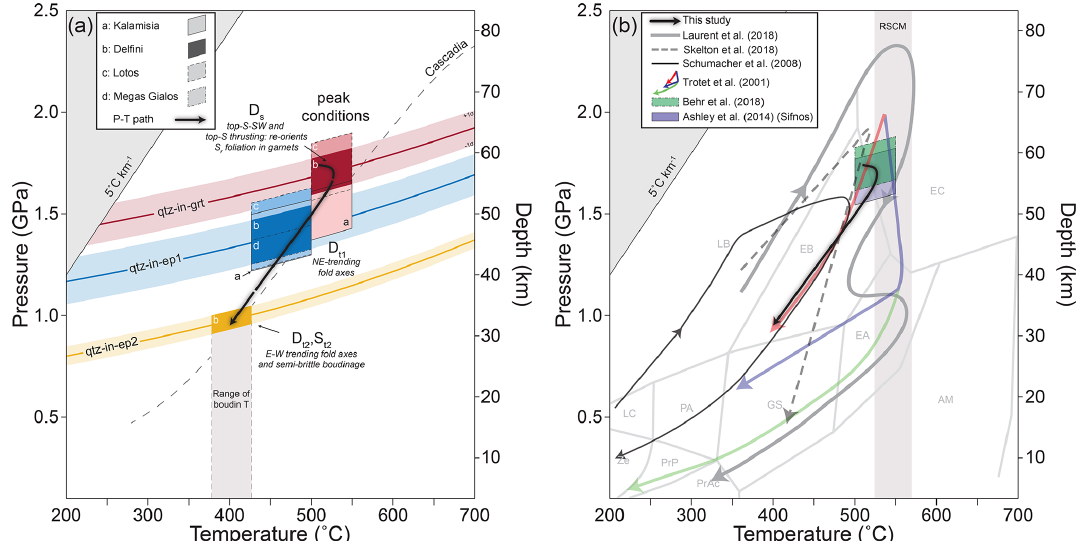
Figure 7. (a) P – T conditions deduced from elastic thermobarometry and oxygen isotope thermometry superimposed on modeled Cascadia slap-top geotherm (Syracuse et al., 2010) and (b) reference P – T conditions. (a) P trap from groups 1, 2, and 3 that reflect peak (qtz-in- garnet), retrograde blueschist–greenschist facies (qtz-in-ep1, D t1 ), and late greenschist facies (qtz-in-ep2, D t2 ) conditions. Solid red, blue, and yellow lines and rectangles are the P trap isomekes (calculated from the mean residual inclusion pressure of each group) and our best- estimate entrapment conditions, respectively. Transparent lines are P trap errors (1 σ around the mean) for analyses from Delfini samples. Gray box bounds the range of temperatures calculated from oxygen isotope thermometry of quartz–calcite boudin-neck precipitates. D s is the oldest stage of deformation in outcrop. Subsequent D t deformation is separated into D t1 and D t2 to differentiate between older and younger stages of upright folding, respectively, that form NE–SW (D t1 ) and E–W (D t2 ) lineations under blueschist and greenschist facies conditions. (b) Recalculated P trap values from Behr et al. (2018) (Syros) and Ashley et al. (2014) (Sifnos) and shown in purple (solid border) and green (dashed border) rectangles, respectively. Metamorphic facies are taken from (Peacock, 1993). Metamorphic facies fields (Peacock, 1993): zeolite (ZE), prehnite–pumpellyite (PrP), prehnite–actinolite (PrAc), pumpellyite–actinolite (PA), lawsonite–chlorite (LC), greenschist (GS), lawsonite–blueschist (LB), epidote–blueschist (EB), epidote–amphibolite (EA), amphibolite (AM), and eclogite (EC). RSCM: Raman spectroscopy of carbonaceous material (data from Laurent et al.,